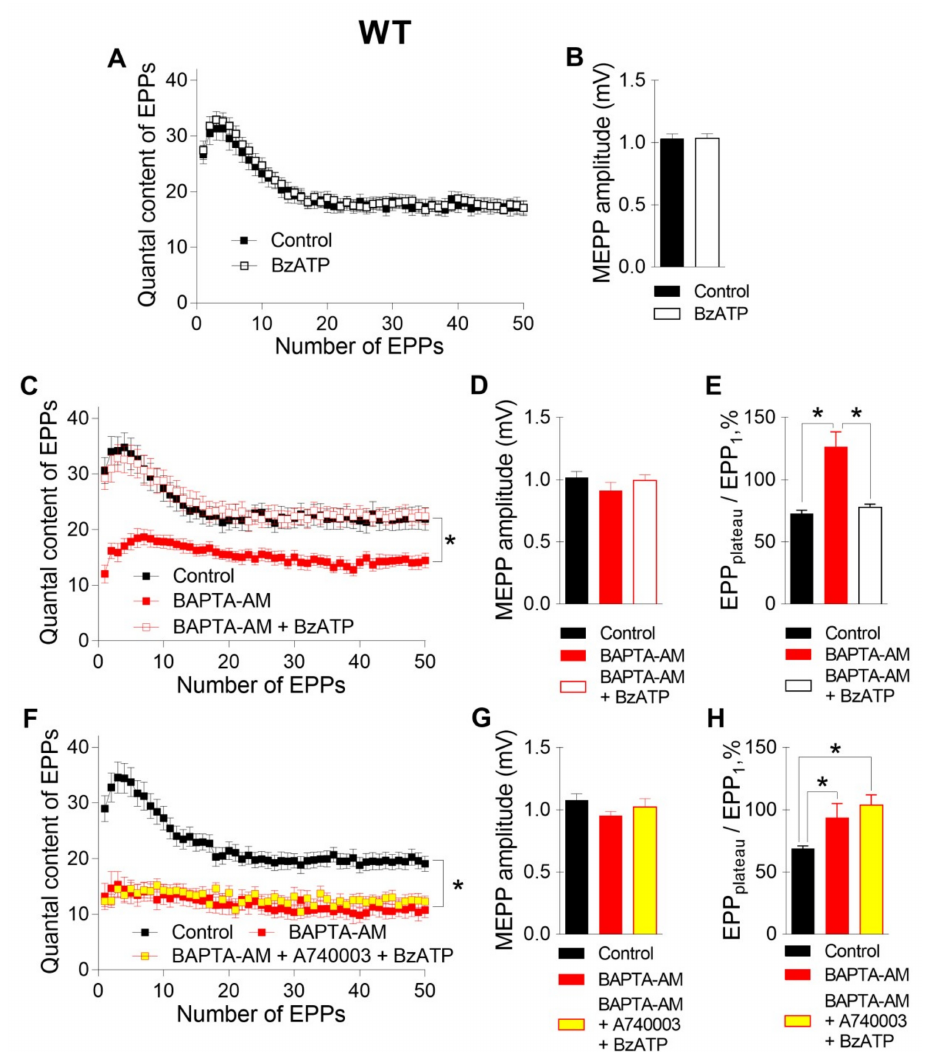
Figure 3. P2X7 receptor-mediated recovery of evoked neuromuscular transmission at the NMJs of WT mice in the presence of a fast Ca 2 + chelator during a short high-frequency EPP train (50 Hz, 1 s). ( A ) Changes in the EPP quantal content in the control group (n = 24) and during the activation of P2X7 receptors by their agonist BzATP (30 µ M) (n = 22). ( B ) MEPP amplitude in the control group and in the presence of BzATP. ( C ) Changes in the EPP quantal content in the control group (n = 16), after incubation with BAPTA-AM (n = 15) and during the subsequent application of BzATP (n = 19). ( D ) MEPP amplitude in the control group, after incubation with BAPTA-AM and during the subsequent application of BzATP. ( E ) The ratio of the average quantal content of the last ten EPPs in the train to the quantal content of the first EPP (EPP plateau / EPP 1 ) normalized to EPP 1 (taken as 100%) in the control group, after incubation with BAPTA-AM and during the application of BzATP in the presence of preloaded BAPTA. ( F ) Changes in the EPP quantal content in the control group (n = 22), after incubation with BAPTA-AM (n = 15) and during the subsequent application of BzATP in the presence of P2X7 receptor antagonist A740003 (1 µ M) (n = 15). ( G ) MEPP amplitude in the control group, after incubation with BAPTA-AM and during the subsequent application of BzATP in the presence of A740003. ( H ) The ratio of the average quantal content of the last ten EPPs in the train to the quantal content of the first EPP (EPP plateau / EPP 1 ) normalized to EPP 1 (taken as 100%) in the control group, after incubation with BAPTA-AM and during subsequent application of BzATP in the presence of A740003. The symbols, histograms and error bars represent the mean ± SEM. * p <